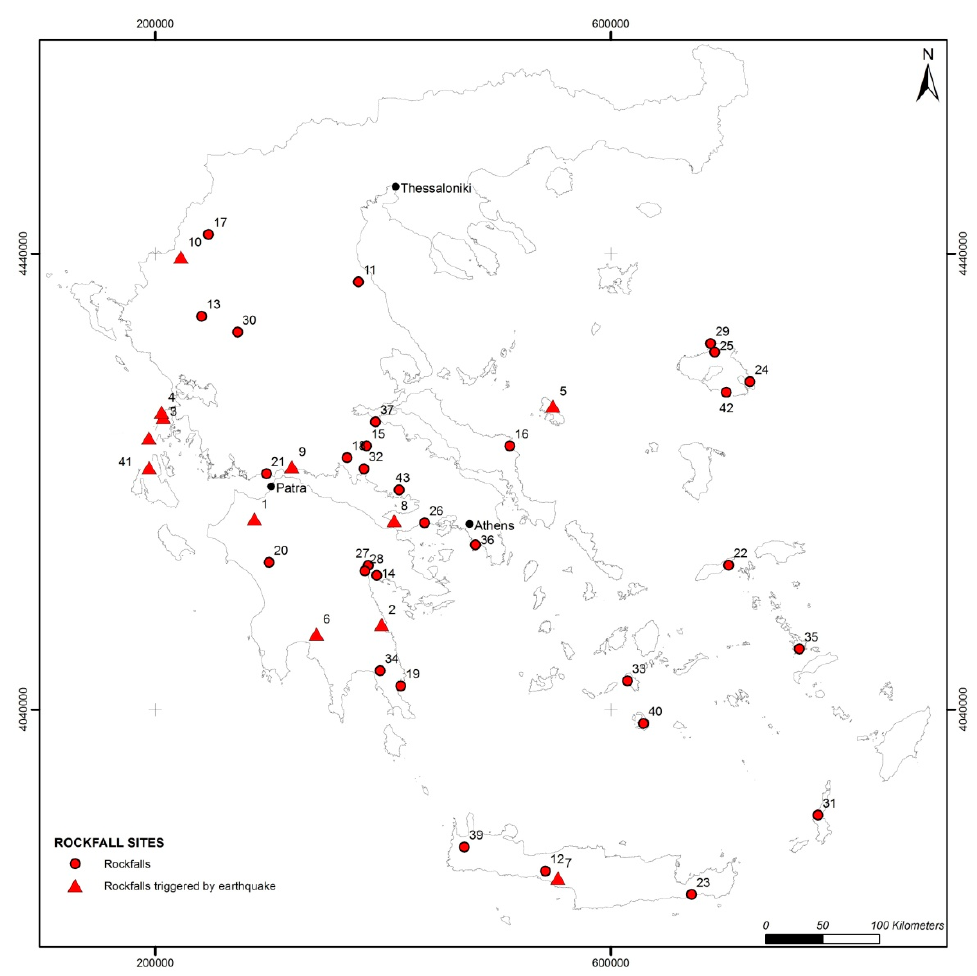
Figure 1. Inventory of recorded rockfall events in Greece.